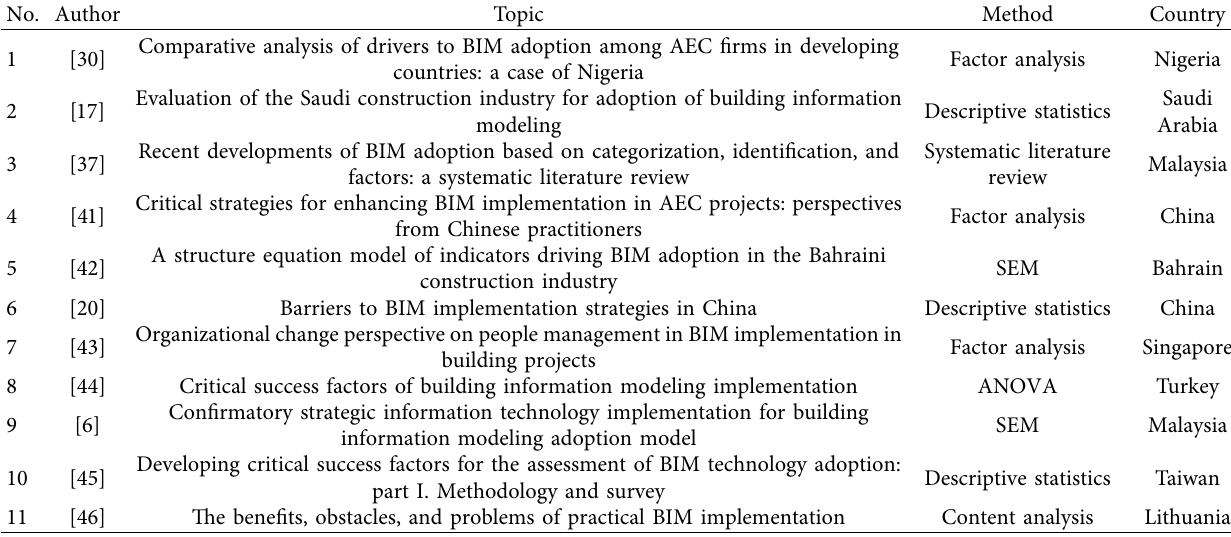
Table 1: Summary of the selected papers for the current study.